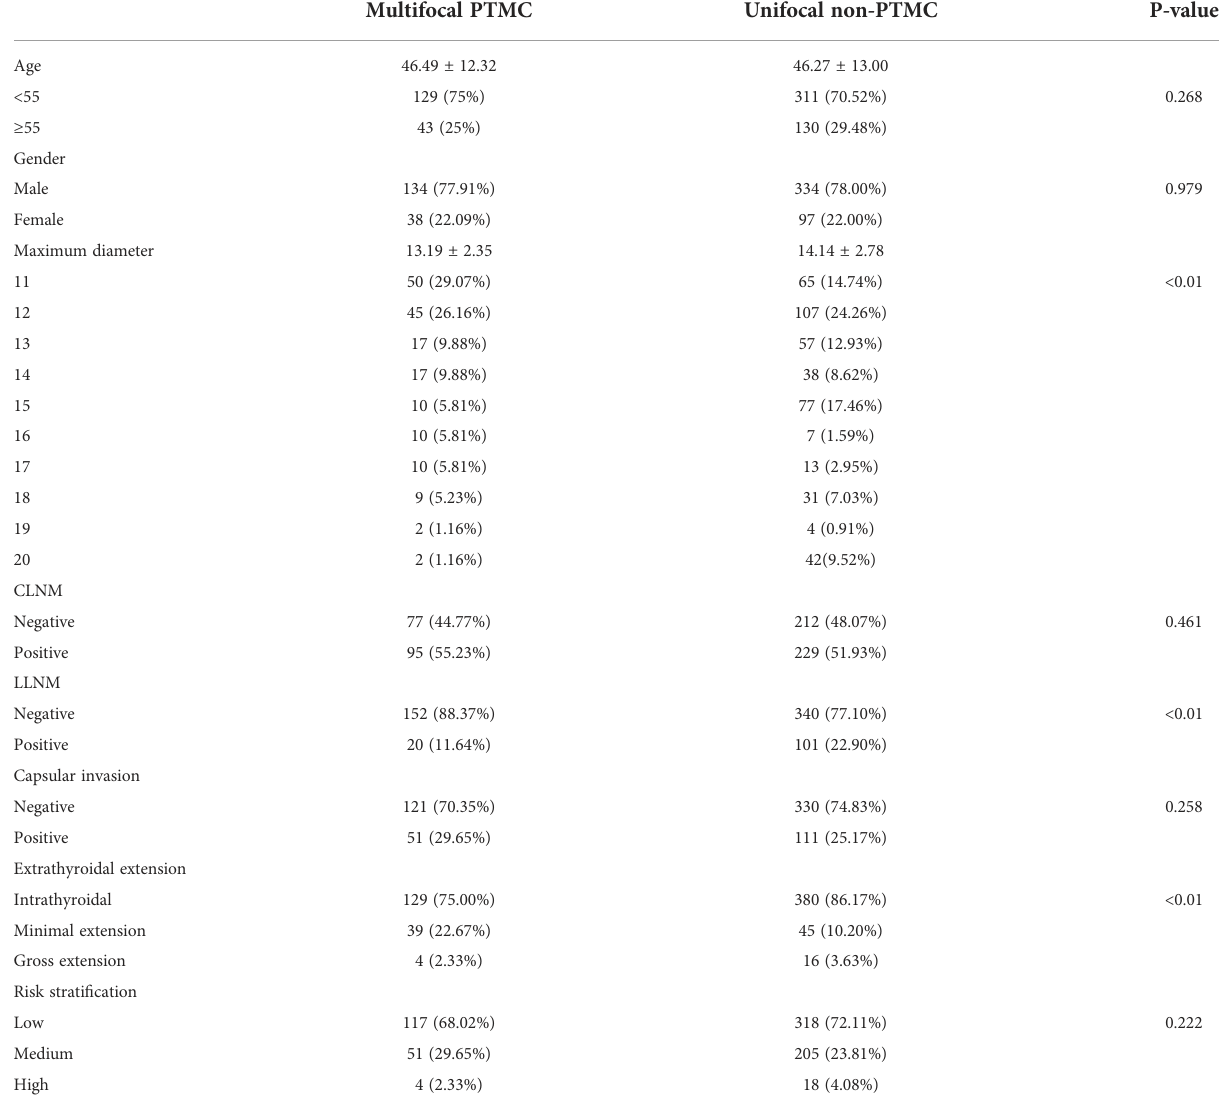
TABLE 2 Comparison of baseline characteristics between multifocal PTMC and unifocal non-PTMC before